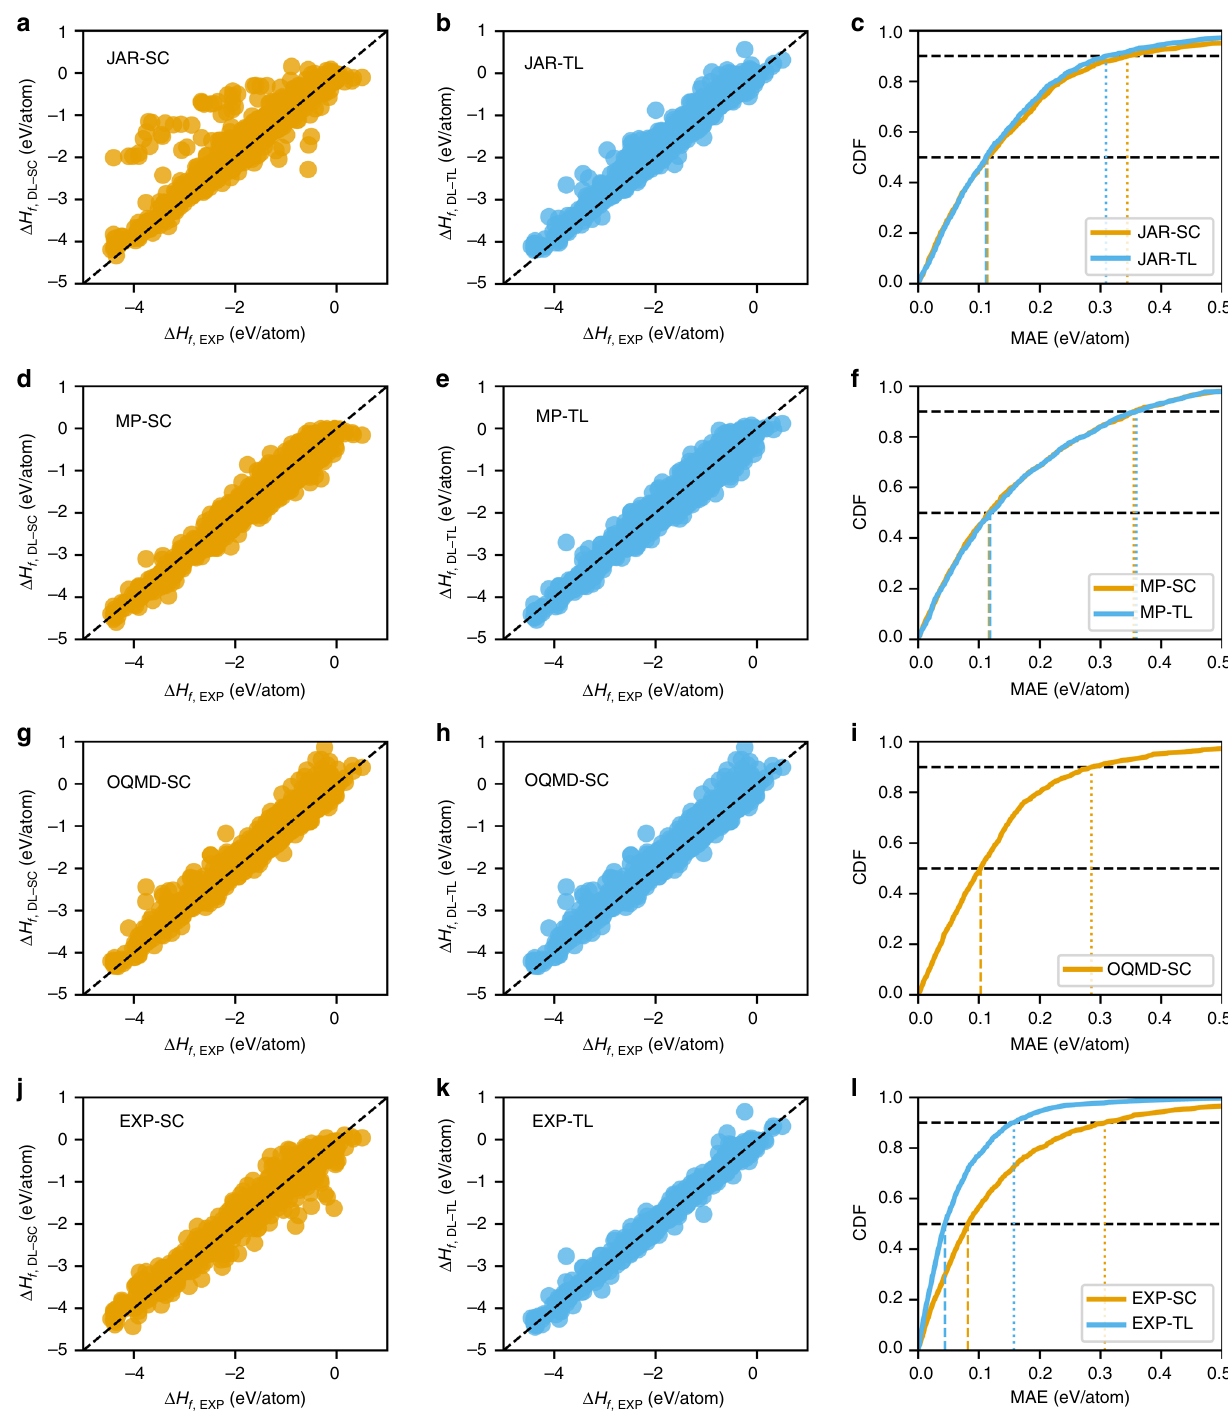
Fig. 5 Prediction error analysis on the experimental data set. The experimental data set contains 1,643 observations. For the models trained using experimental data set, the predictions are aggregated on test (validation) sets from each split in the 10-fold cross-validation. For the models trained using JARVIS and Materials Project, since we have 10 models from the 10-fold cross-validation during training, we take the mean of their predictions for each data point in the experimental data set. For OQMD-SC, we make 10 predictions for each point in the experimental data set and take their mean. The four rows represent the four data sets: a – c JARVIS (JAR), d – f Materials Project (MP), g – i OQMD, and j – l the experimental observations (EXP); fi rst a , d , g , and j and second b , e and k (except h) columns of each row show the predictions using the model trained on the particular data set from scratch (SC) and using transfer learning (TL) respectively; the third column c , f , i , and l shows the corresponding CDF of the prediction errors using models trained from scratch (SC) and using transfer learning